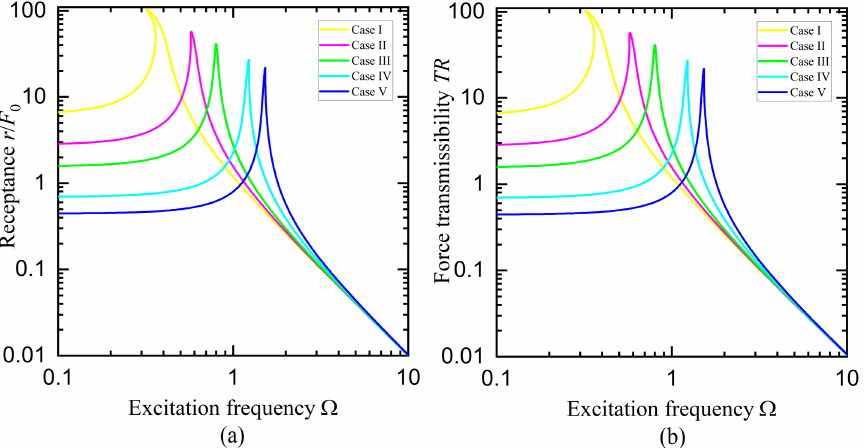
Figure 8. ( a ) Receptance function r / F 0 of the system and ( b ) force transmissibility TR with ξ = 0.01. The yellow, magenta, green, cyan and blue surfaces correspond to Case one, two, three, four, and five, respectively.